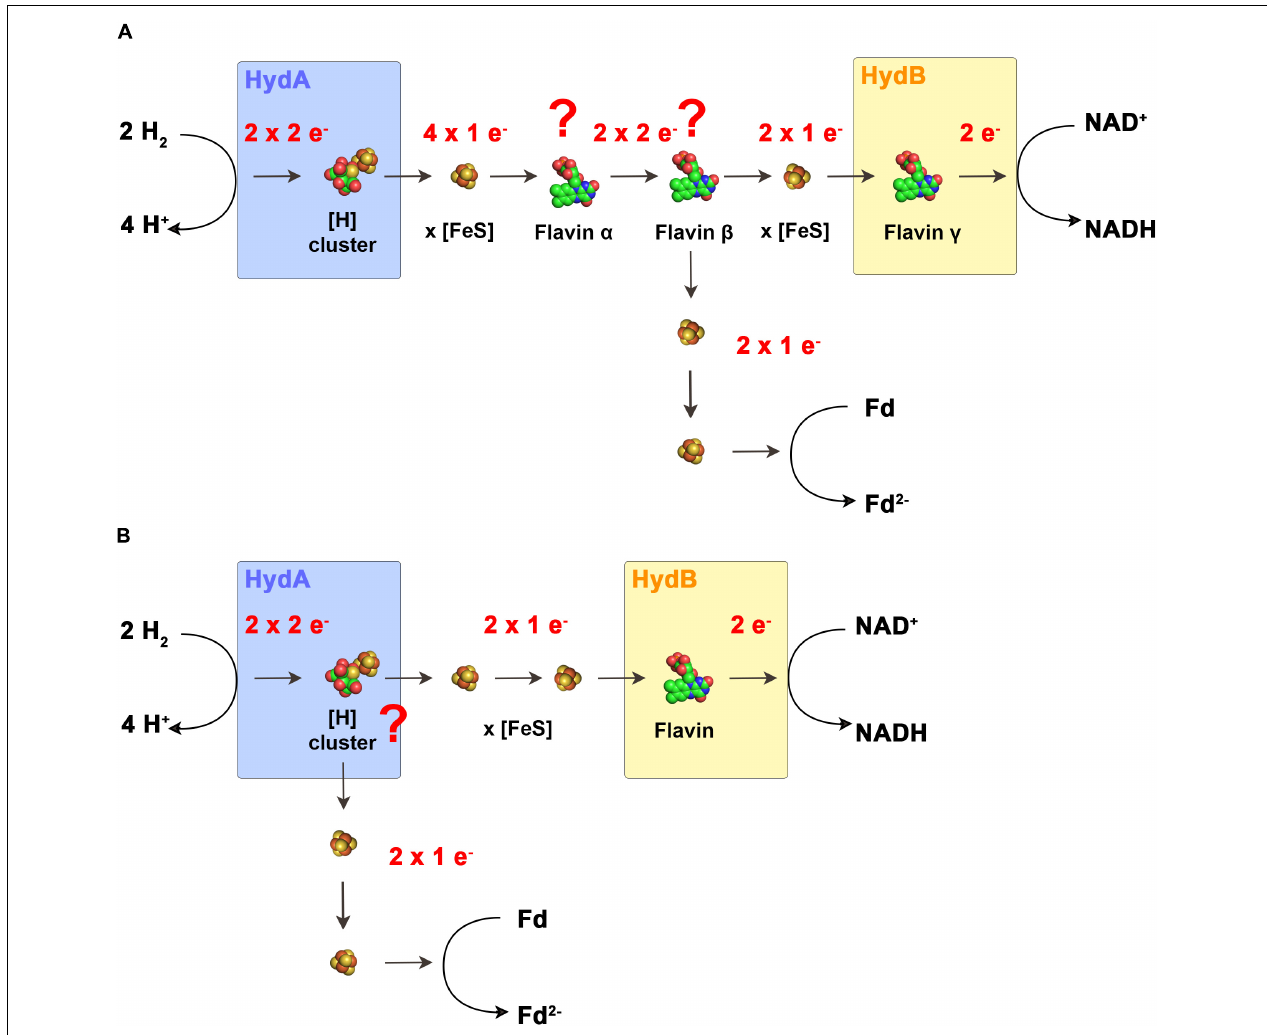
FIGURE 4 | Models for the electron flow in electron bifurcating hydrogenases. In the scenario that electron-bifurcation is facilitated by a flavin (A) according to the standard model of FBEB, the enzymes would have to contain two additional flavins that cannot be predicted from the primary structure. Flavin α functions as switch from one electron transferring iron–sulfur clusters to the actual bifurcating flavin β . Here, the two electrons are bifurcated to other iron–sulfur clusters and to the final acceptors. Flavin γ functions as switch from the one electron transferring iron–sulfur clusters to NAD + . In the second scenario (B) . The H-cluster is the site of electron bifurcation. Here only one flavin is required for the switch from the one electron transferring iron–sulfur clusters to NAD + . Fd,